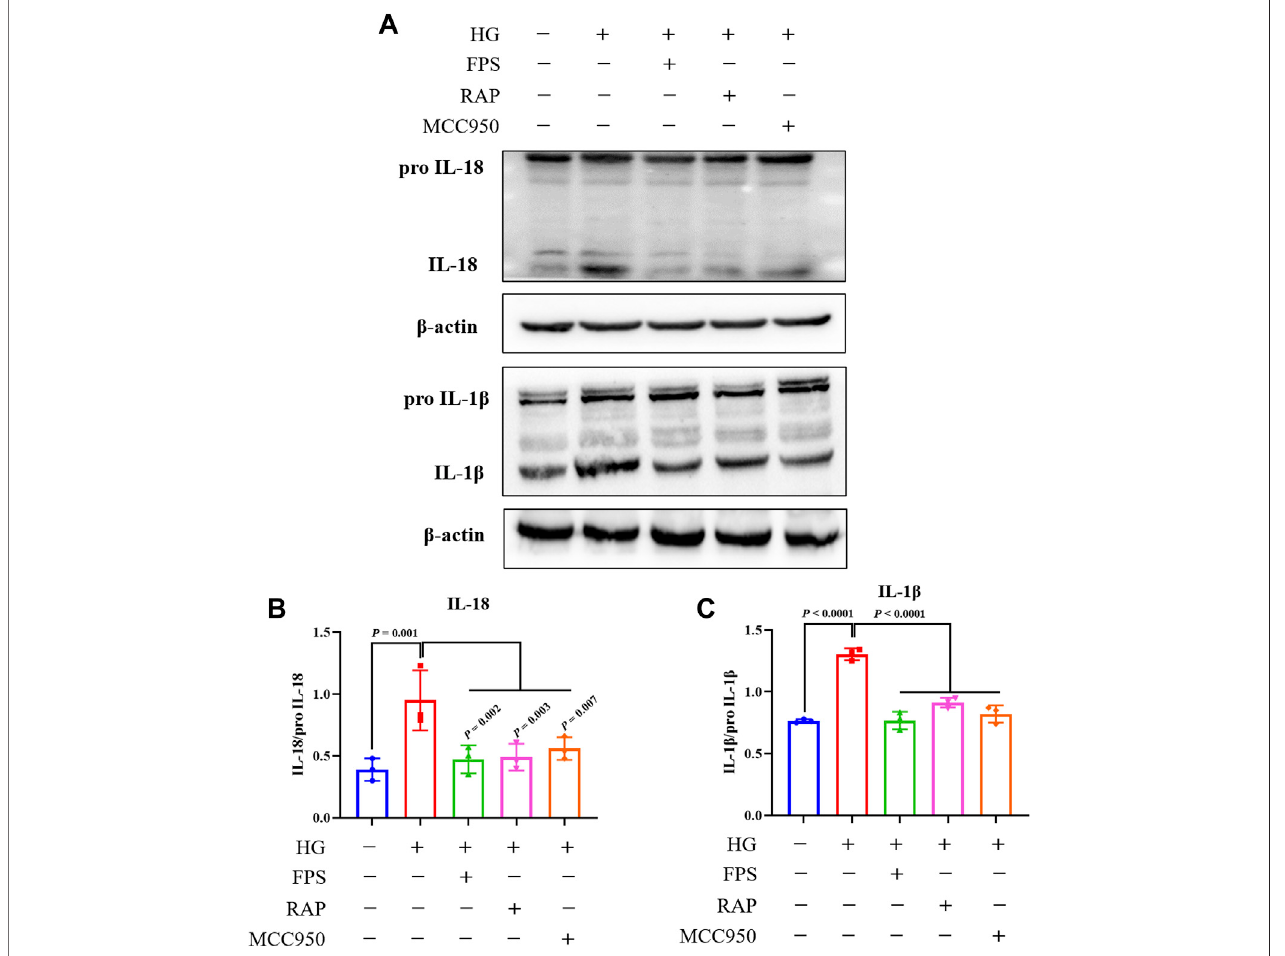
FIGURE12| Effects ofFPSandRAPontheexpressionlevels ofIL-18andIL-1 β invitro . (A) TheWBanalysisofproIL-18,proIL-18,proIL-1 β ,and IL-1 β inMPC-5 cells exposed toHGwithor withoutFPS or RAPorMCC950for24 h (B,C) TherateofIL-18 and IL-1 β toproIL-18 orproIL-1 β , respectively.Thedataare expressed as the mean ±